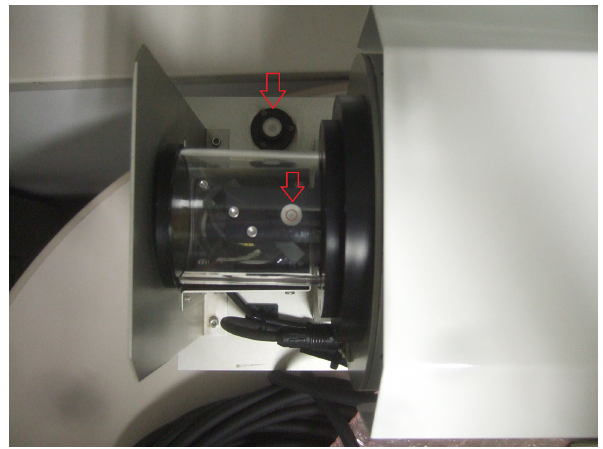
Figure 2. Two horizontal levels embedded in the base plate (upper arrow) and in a plate holding the reflecting mirror (lower arrow) were used to adjust the zero angle of the reflecting